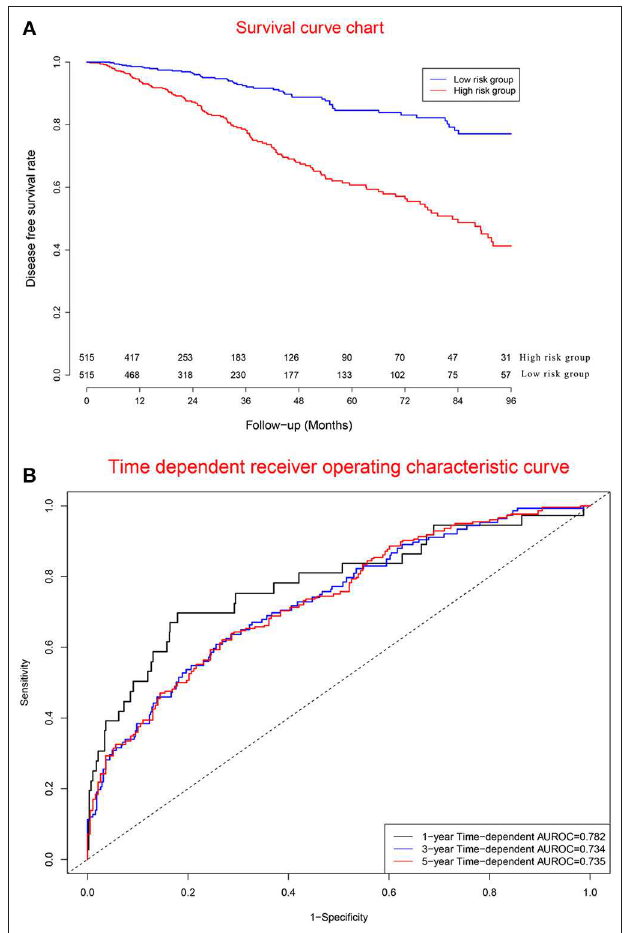
FIGURE 6 | Clinical performance in model cohort. (A) Survival curves for high risk group and low risk group. (B) Time-dependent receiver operating characteristic